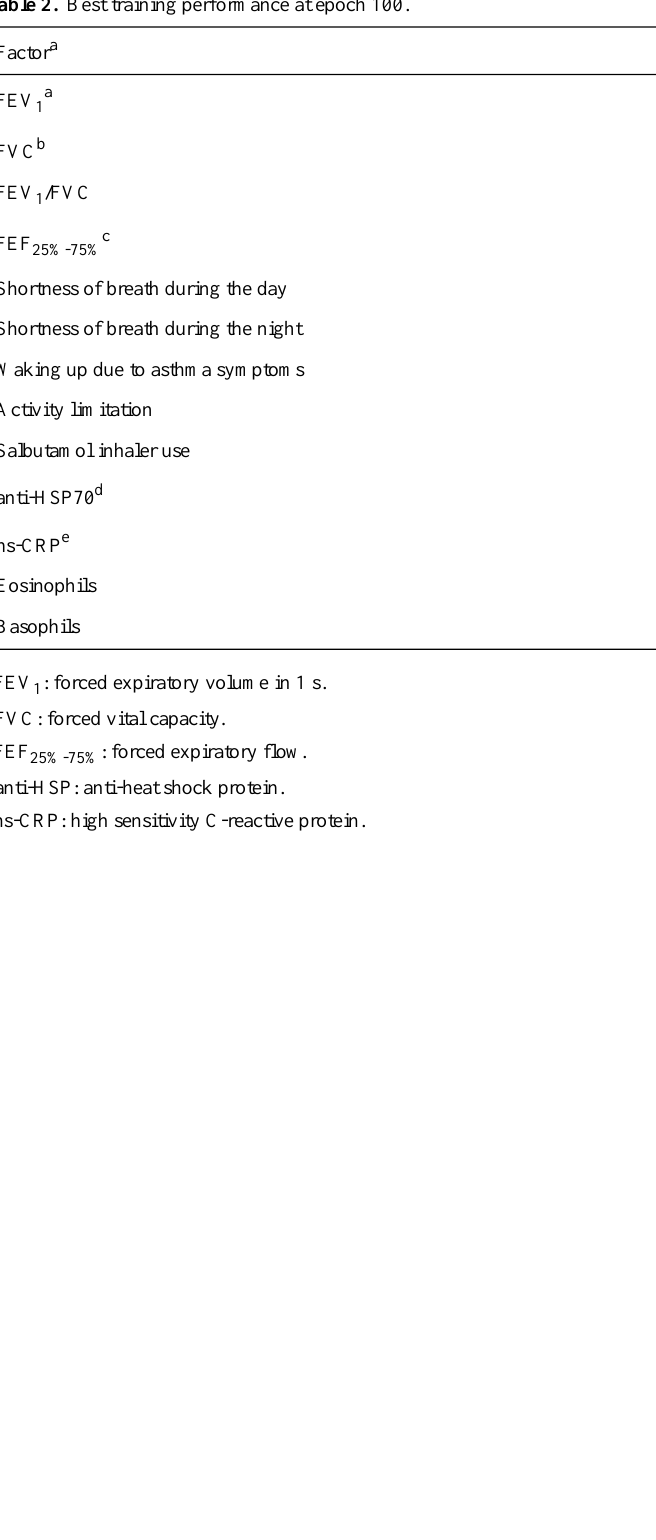
Table 2. Best training performance at epoch